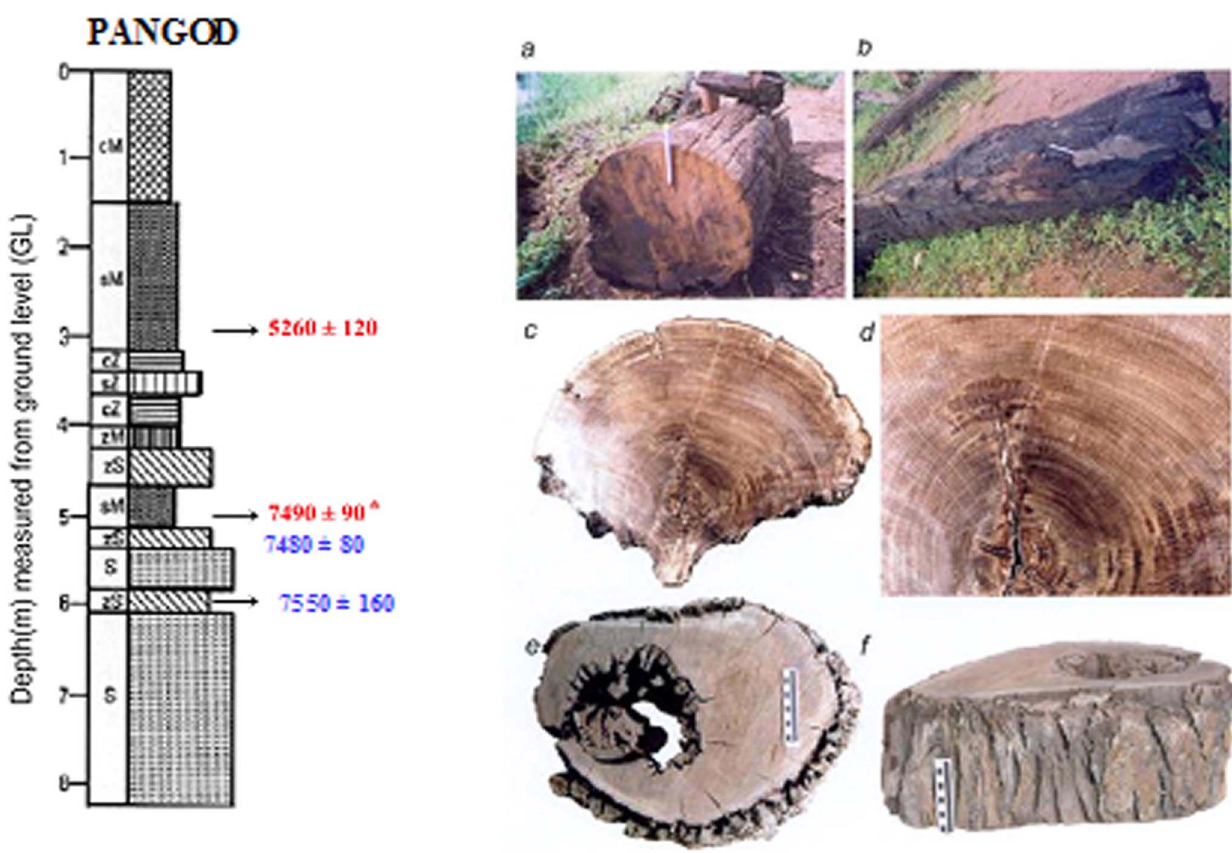
Figure 9. Litholog of Pangod quarry showing carbonized and non carbonized subfossil logs at two different stratigraphic levels along with radiocarbon dates. (a) Sub fossil log. (b) Partially carbonized wood. (c) Cross section showing indistinct growth rings. (d) Enlarged sector of growth rings. (e) and (f) Carbonized wood along with bark showing disintegration of wood.